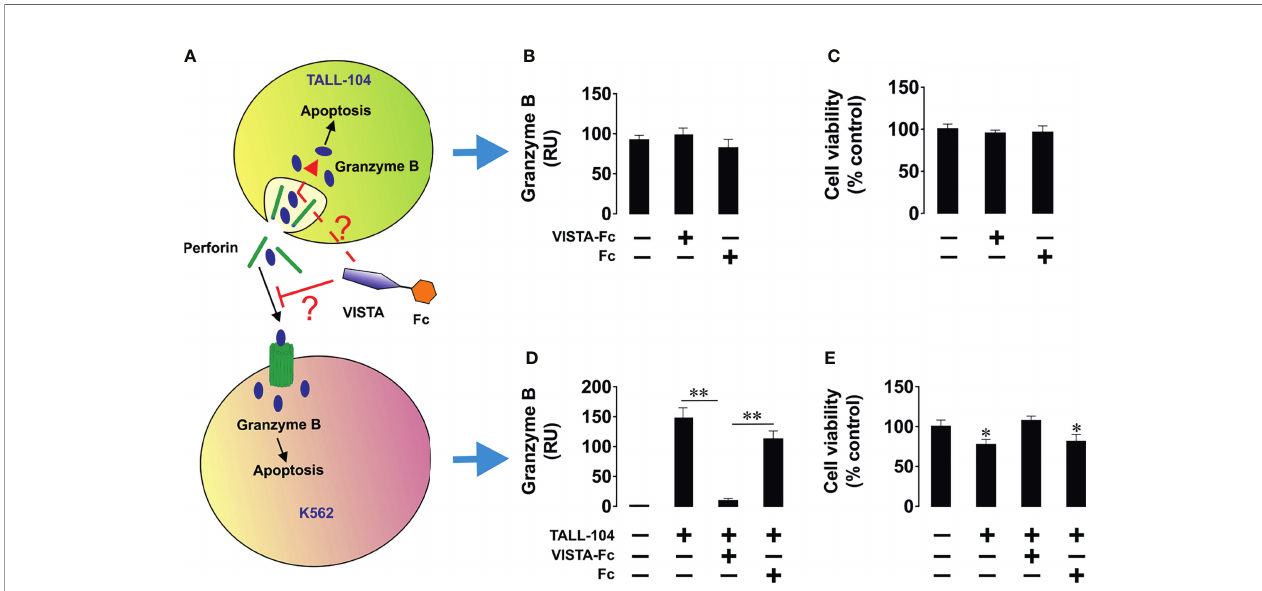
FIGURE 7 | Soluble VISTA attenuates the release of granzyme B into chronic myeloid leukaemia cells by cytotoxic T cells but does not affect lymphocyte viability. K562 chronic myeloid leukemia cells, which express traces and do not release detectable amounts of galectin-9 (as con fi rmed by ELISA), were used as targets. K562 cells were exposed to 100 nM PMA for 24 h in 96 well Maxisorp plates for immobilization. Medium was replaced with ATCC-formulated Iscove ’ s Modi fi ed Dulbecco ’ s Medium containing 100 units/ml recombinant human IL-2; 2.5 m g/ml human albumin; 0.5 m g/ml D-mannitol and foetal bovine serum to a fi nal concentration of 20% with or without TALL-104 cytotoxic T cells (cells in suspension). When TALL-104 cells were present, the ratio was 1 TALL-104: 1 K562 cell. Some of the wells containing TALL-104 cells were supplied with 5 µg/ml VISTA-Fc or an equimolar amount of Fc. Cells were co-cultured for 16 h before separation. In-cell activity of granzyme B and cell viability were measured in both cell types. (A) Scheme of the experiment; (B) in-cell activity of granzyme B in TALL-104 cells; (C) viability of TALL-104 cells; (D) in-cell activity of granzyme B in K562 cells; (E) viability of K562 cells. Data are shown as mean values ± SEM for 4 independent experiments. *p < 0.05; **p <